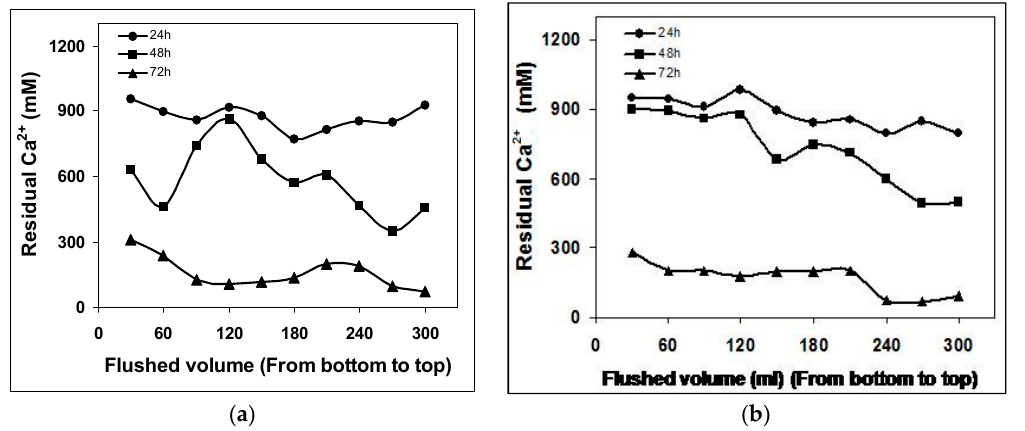
Figure 3. ( a ) Calcium concentration in the effluent for monoculture S. pasteurii , which was flushed out after 24 h, 48 h and 72 h respectively; ( b ) Calcium concentration in the effluent for coculture of S. pasteurii and B. subtilis , which was flushed out after 24 h, 48 h and 72 h, respectively.